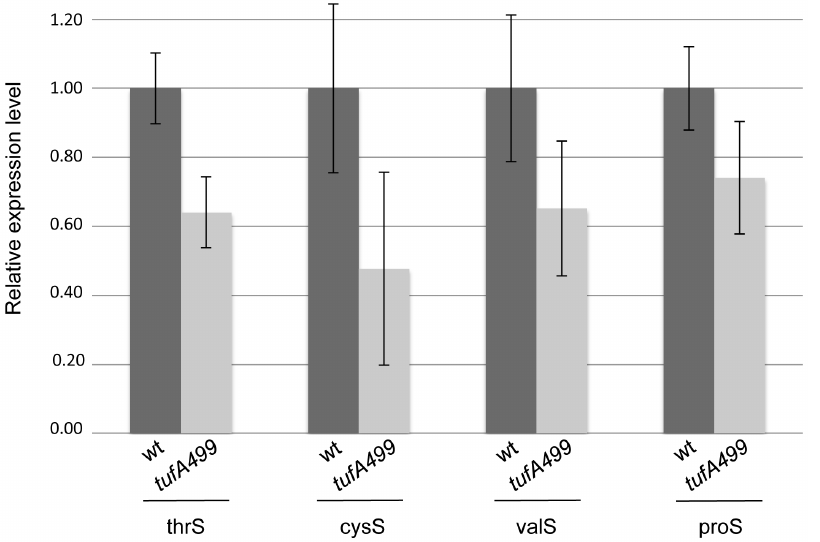
Figure 4. The tufA499 mutation is associated with a reduced expression of four tRNA aminoacyl synthetases. Expression levels of the synthetase genes thrS , cysS , valS and proS were measured by quantitative real-time PCR in wild-type TH7507 ( tufA + ) and TH7509 ( tufA499 ). Values are averages of six independent replicates and normalized to the wild-type levels. Standard deviations represented as error bars. The differences between the mRNA levels in the wild-type and the tufA499 strains are statistically significant according to an unpaired t-test, thrS: p=0.0005, cysS: p=0.0105, valS: p=0.0225, proS: p=0.0169.